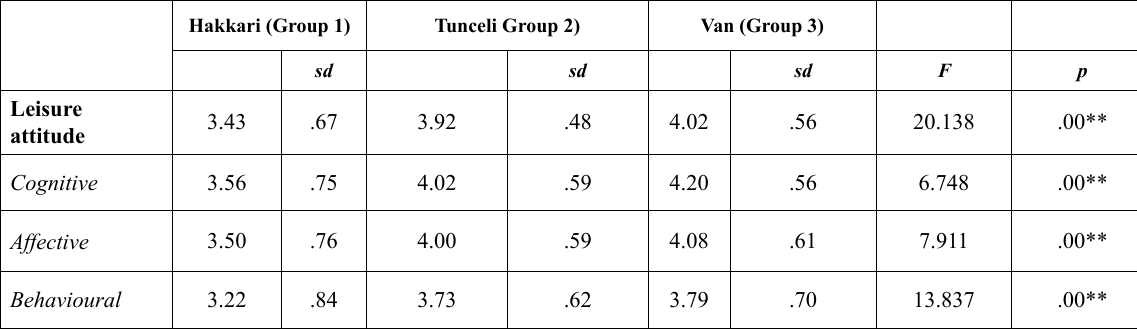
Table 7. Leisure attitude levels of ındividuals living in eastern cities by the variable of the city of